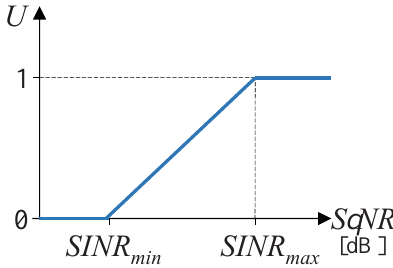
Figure 2. Relation between utility and SINR